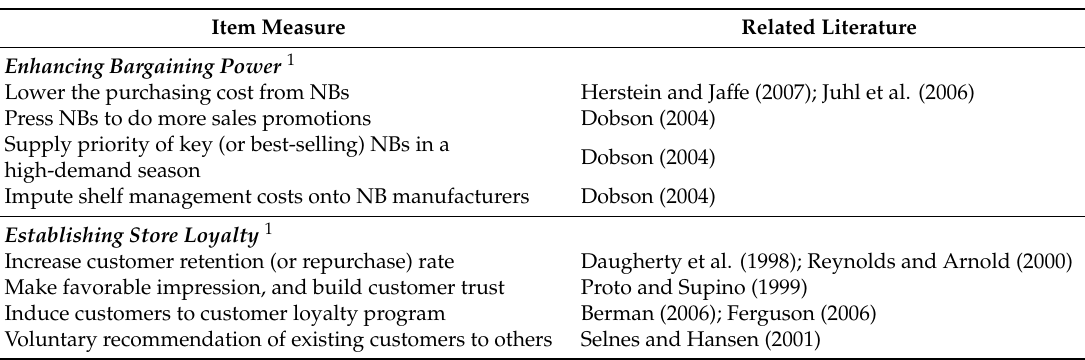
Table A1. Item Measures and Related